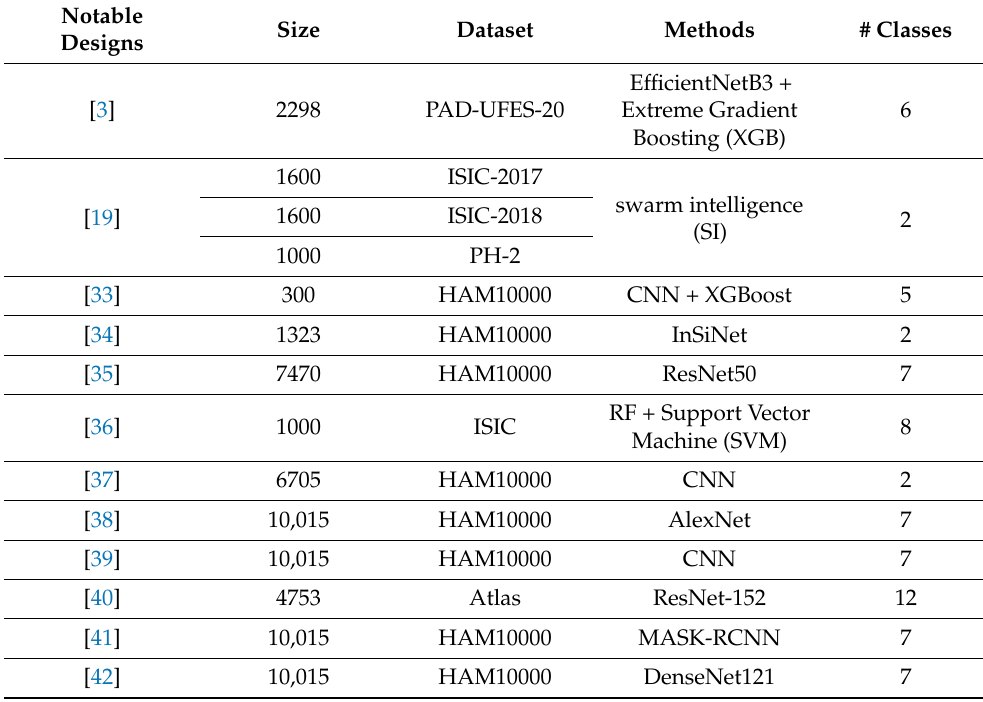
Table 1. Methods, data, and results for skin cancer detection available